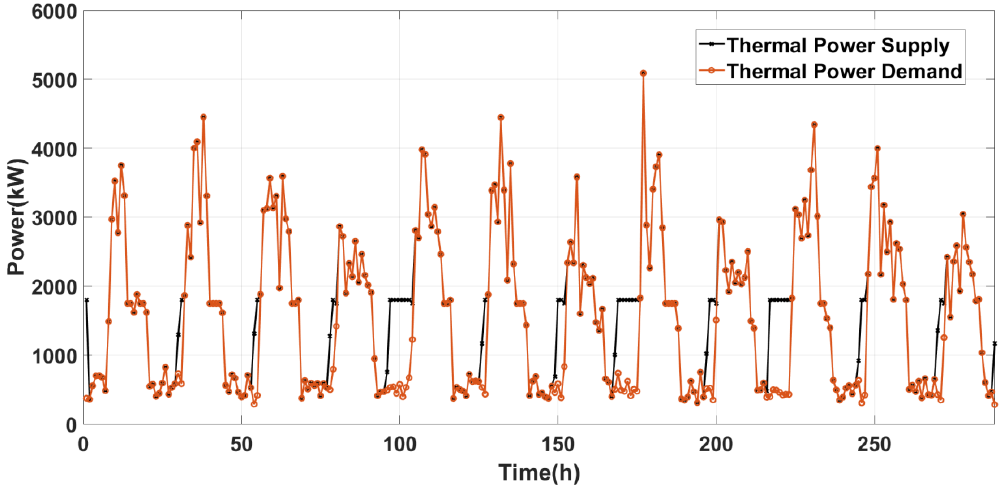
Figure 13. Thermal power generation and consumption scenario of Case-01.